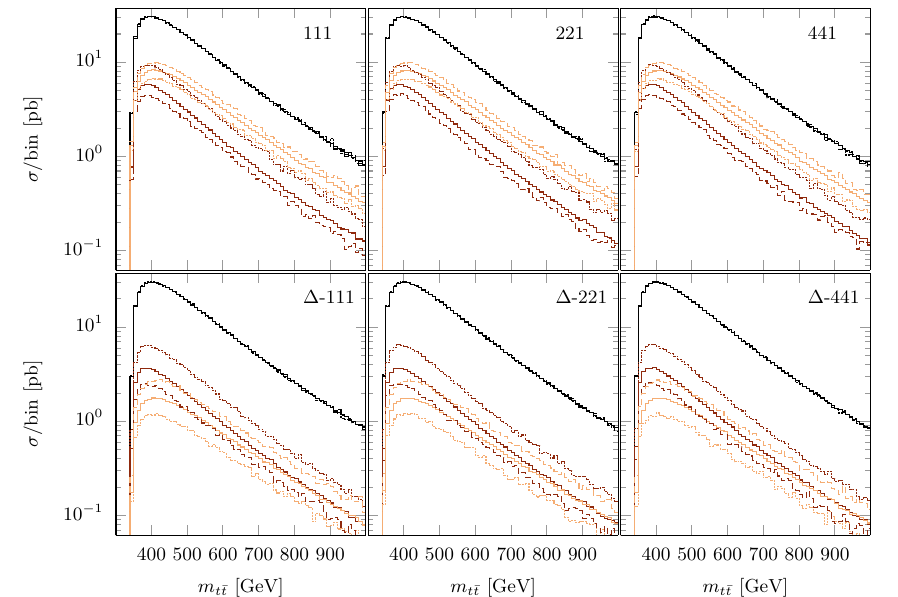
Figure 8 . As in (cid:12)gure 6 for the invariant mass of the t (cid:22) t pair. For hard events before parton shower, only H ones are